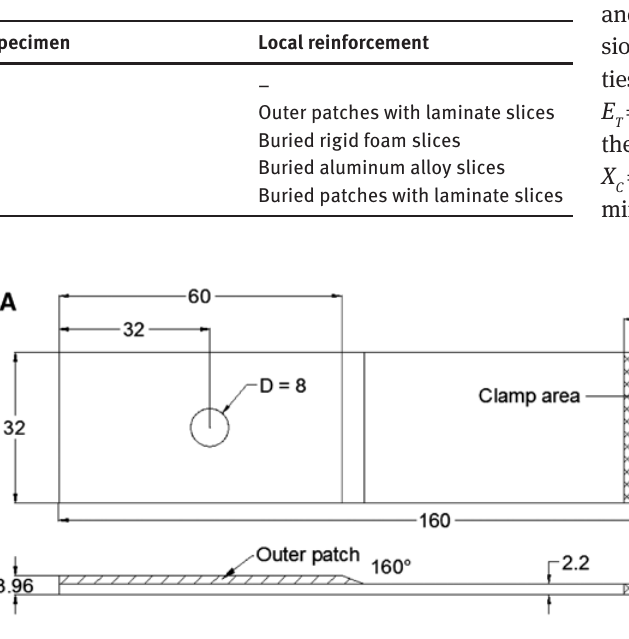
Table 1: Serial number of specimens.